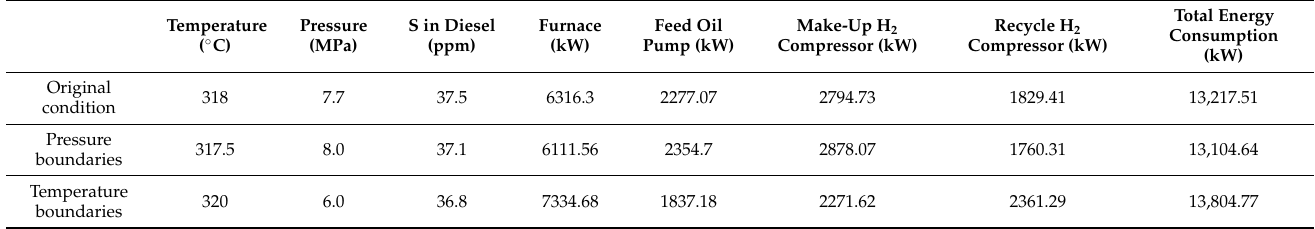
Table 5. Energy consumption of the operating condition